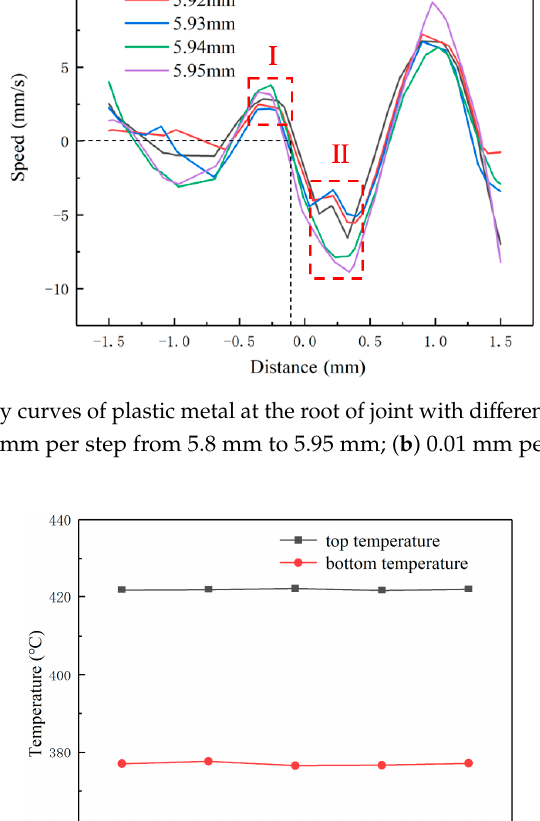
Figure 12. Flow velocity curves of plastic metal at the root of joint with different pin lengths (1000 rpm, 120 mm/min). ( a ) 0.05 mm per step from 5.8 mm to 5.95 mm; ( b ) 0.01 mm per step from 5.91 mm to 5.95 mm.